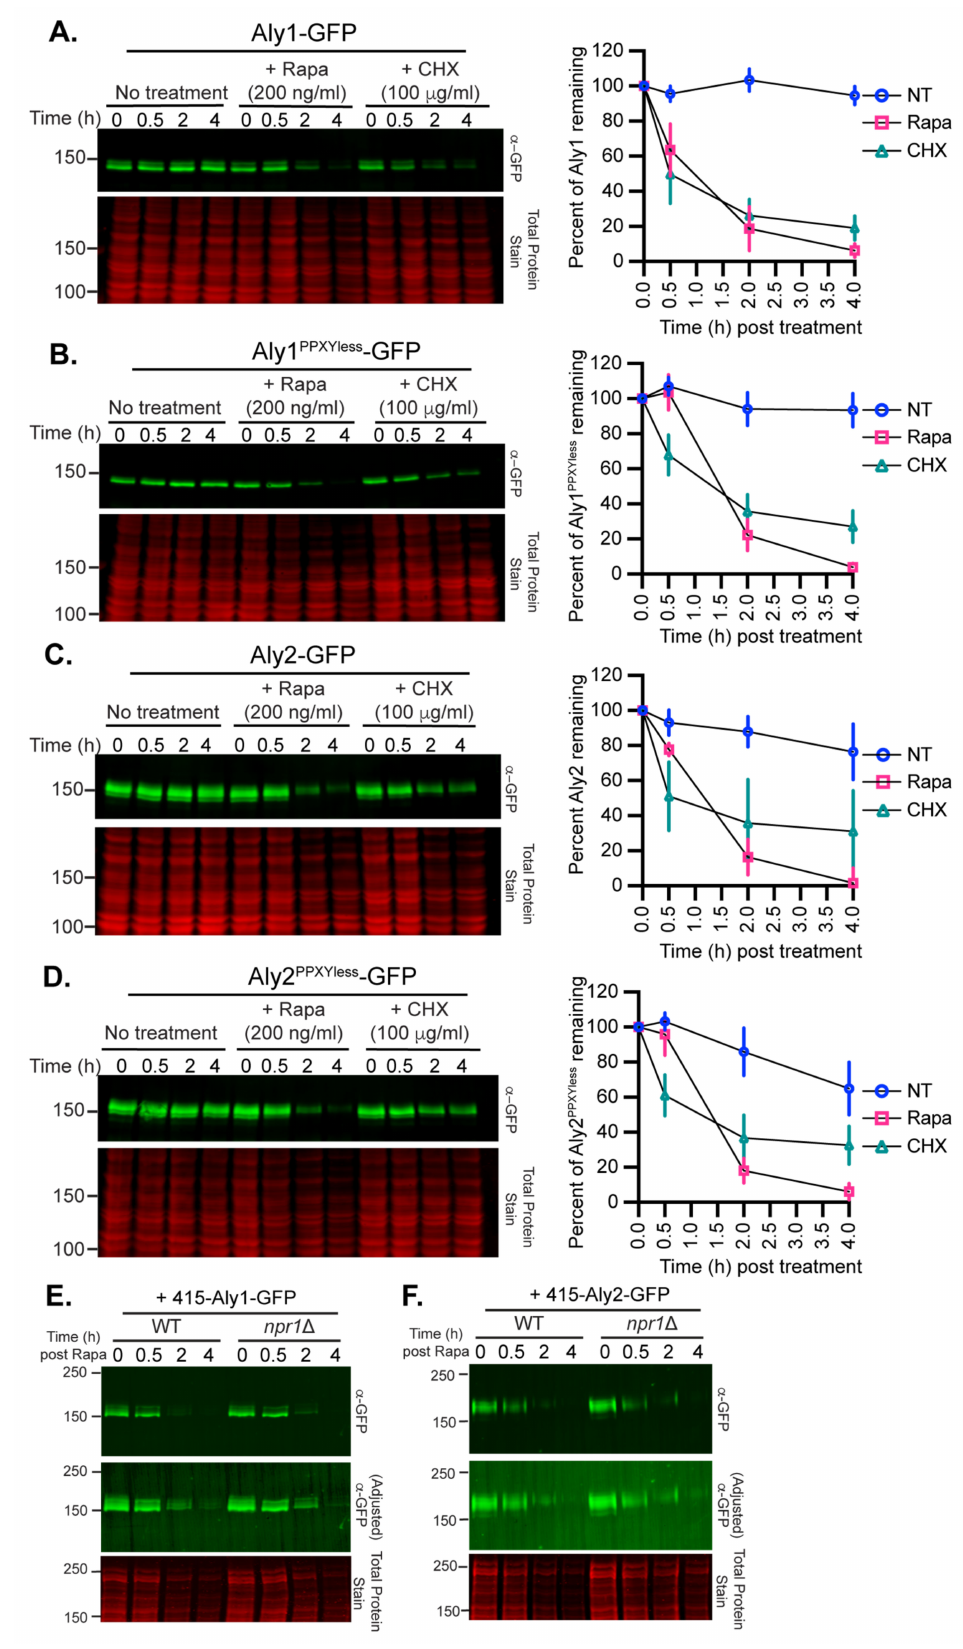
Figure 7. Rapamycin treatment destabilizes Aly1 and Aly2, irrespective of Rsp5 binding: ( A – D ) Whole-cell extracts from WT cells treated with nothing (no treatment; NT), rapamycin